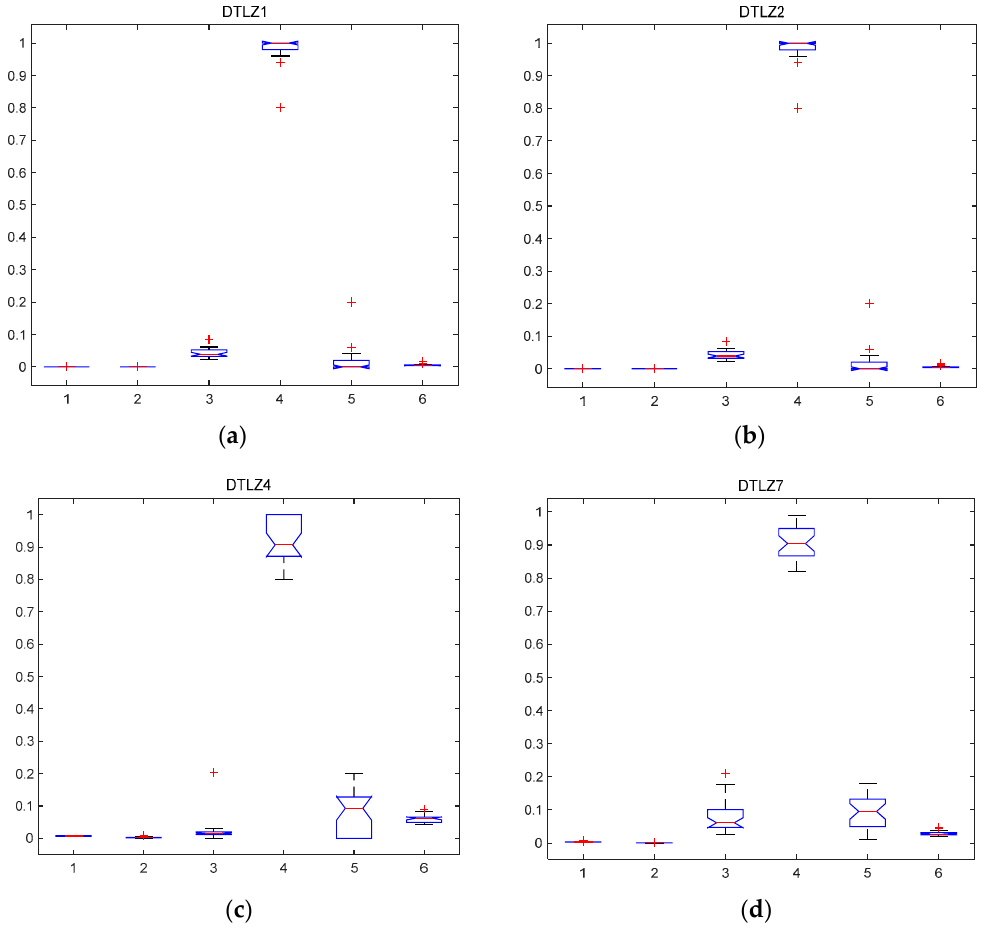
Figure 2. Boxplot representing the distribution of the metrics on DTLZ test problems (GD = 1, standard deviation of GD = 2, SP = 3, CR = 4, ER = 5 and γ = 6). ( a ) the metrics on DTLZ1 problem; ( b ) the metrics on DTLZ2 problem; ( c ) the metrics on DTLZ4 problem; ( d ) the metrics on DTLZ7 problem.